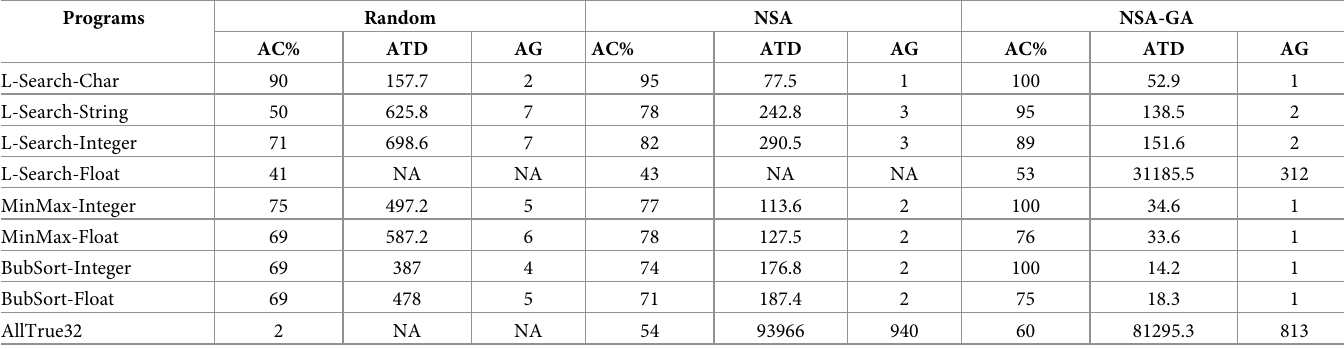
Table 4. Comparison between random testing, NSA and NSA-GA methods for programs with loops and different data